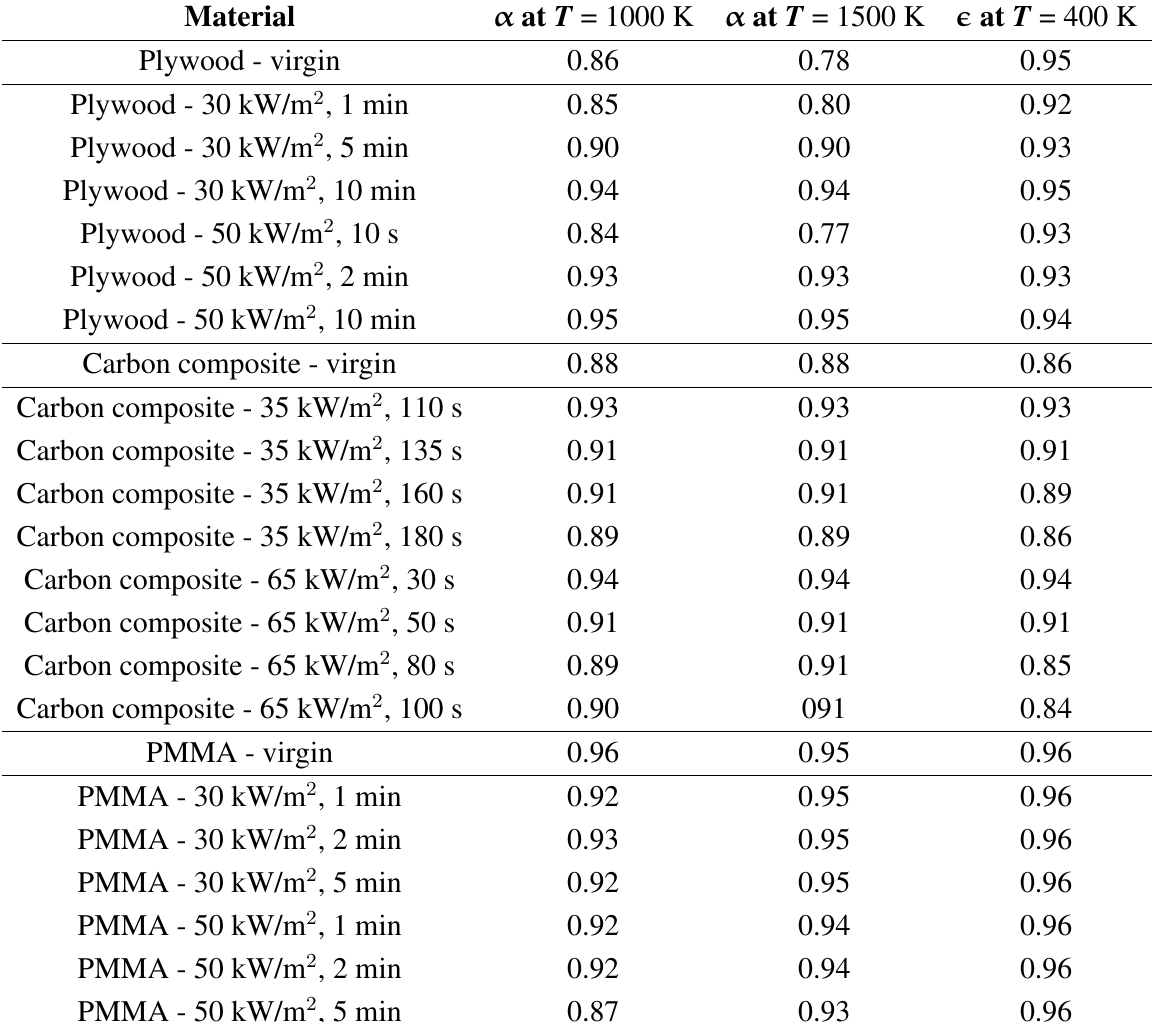
Table 1. Average absorptivity or emissivity computed between 1000 and 6000 cm − 1 , α for two high source temperatures of 1000 K, 1500 K and (cid:15) for a moderate temperature of 400